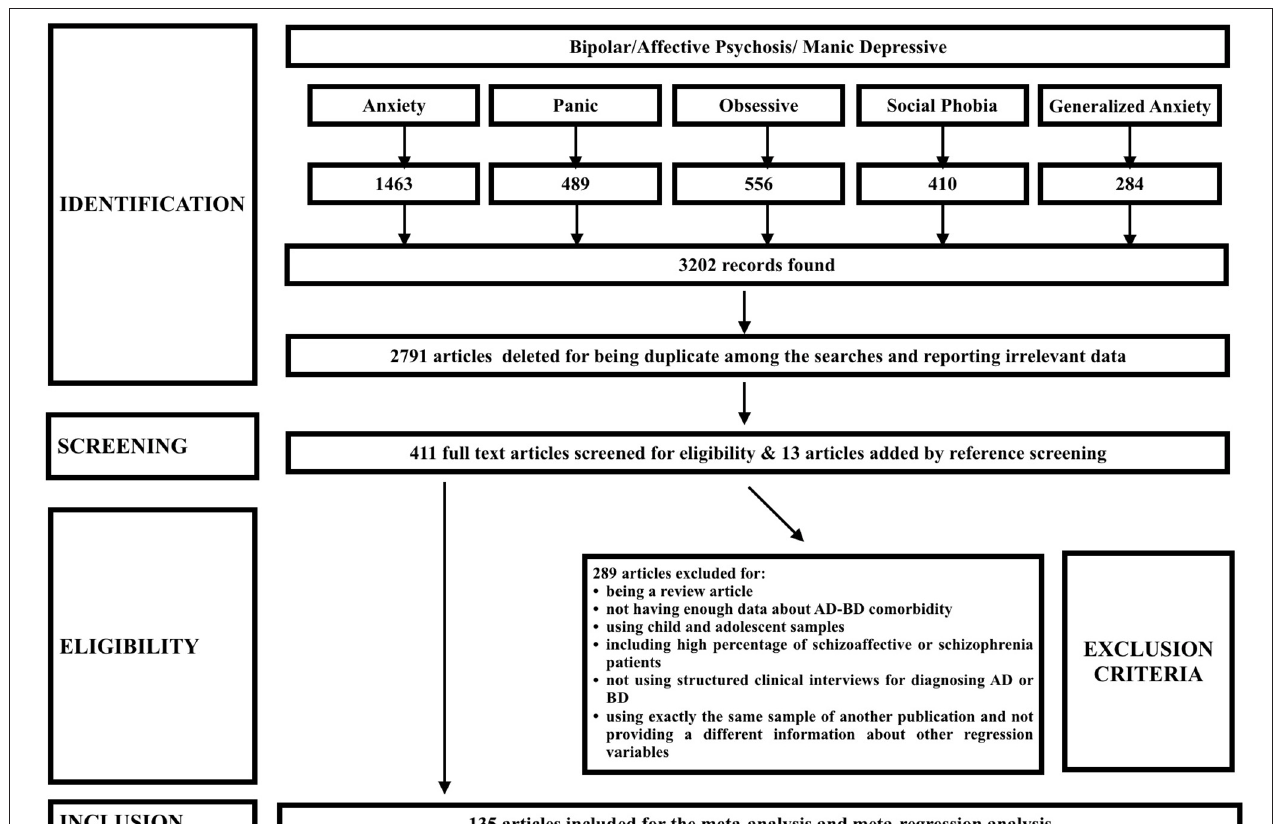
FIGURE 1 | PRISMA flow of found studies based on the research and screening